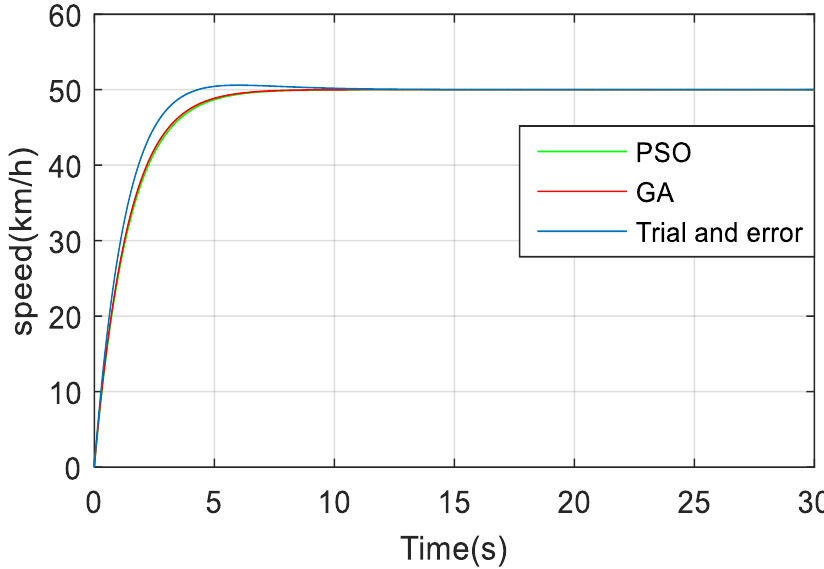
Figure 16. BEV speed response for simple input speed reference.